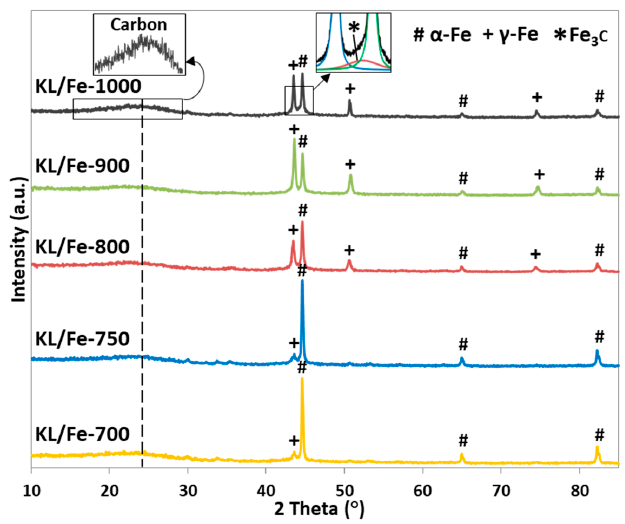
Figure 1. X-ray diffraction (XRD) patterns of KL/Fe-X samples.